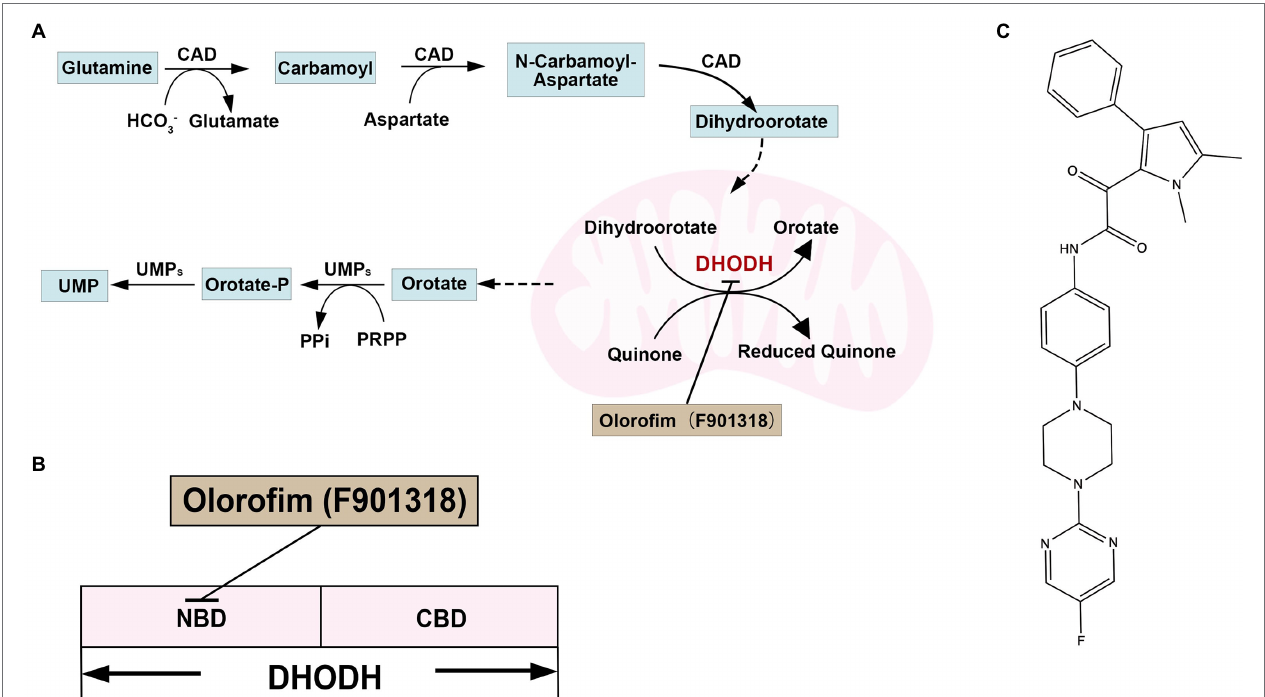
FIGURE 6 | (A) Overview of pyrimidine biosynthesis in yeast; (B) the docking model of olorofim and DHODH; and (C) structure of DHODH inhibitor olorifim